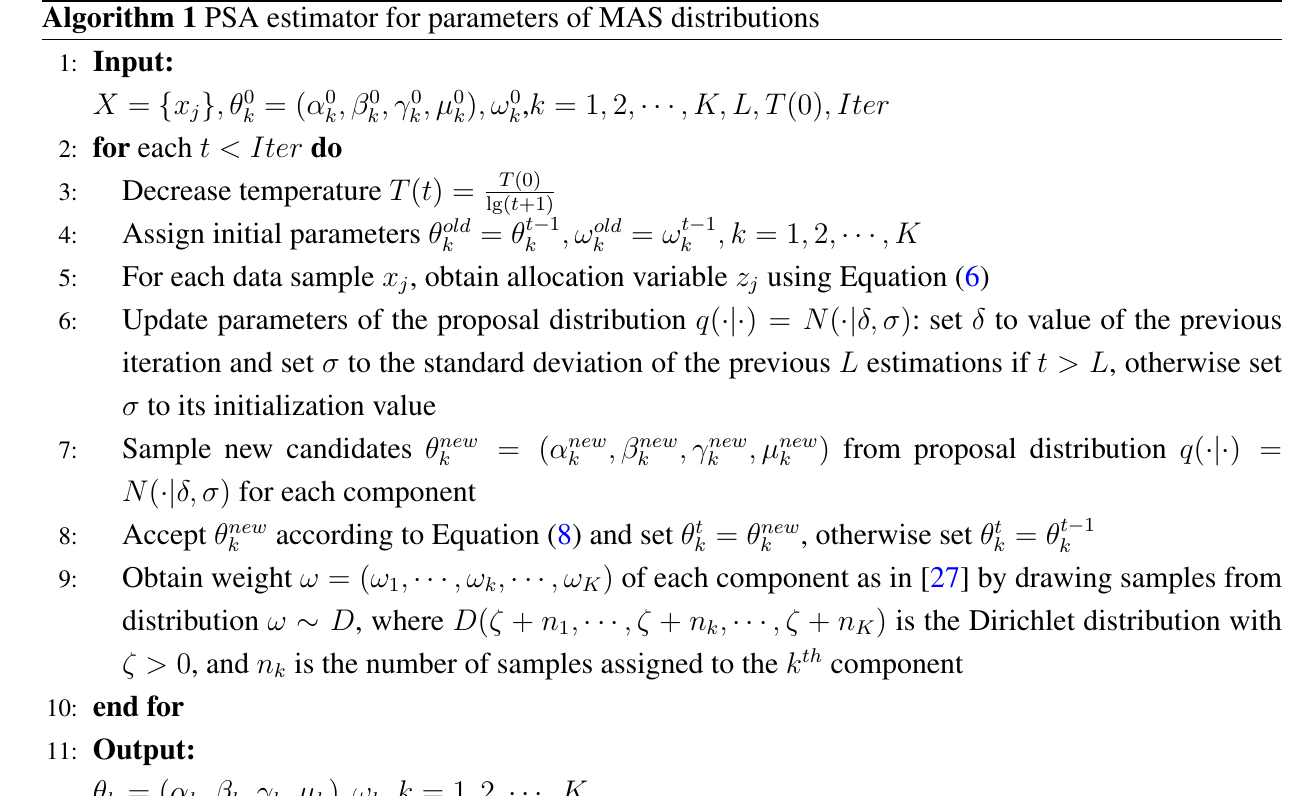
Algorithm 1 PSA estimator for parameters of MAS